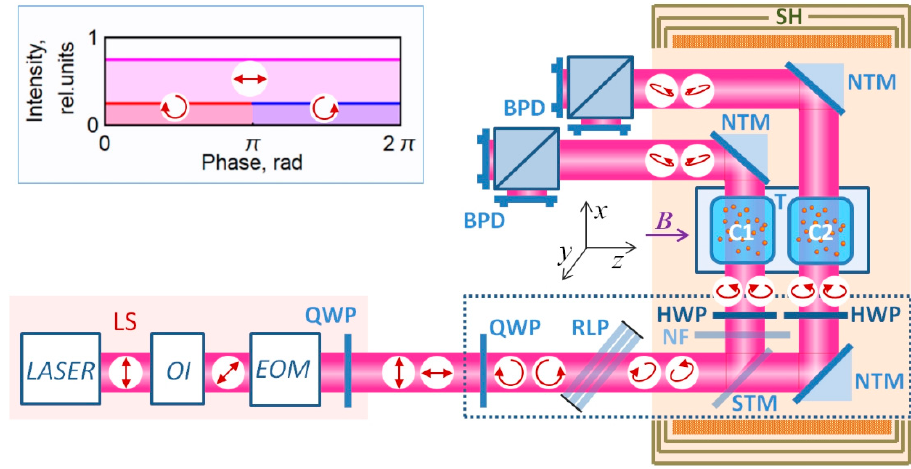
Figure 1. Simplified scheme of the experiment: LS—radiation source, OI—optical isolator, EOM—electro-optical polarization modulator, QWP—quarter-wave plate, RLP—regulated linear polarizer, NF—neutral filter, HWP—half-wave plates, C1, C2—gas cells with Cs vapors, STM is a semitransparent mirror, NTM is a non-transparent (opaque) mirror, BPD are balanced photodetectors, T is a thermostat, SH is a magnetic shield with a solenoid. Arrows indicate beam polarization states corresponding to two modulation half-cycles. Inset: time diagram of the polarization composition of the beam during one modulation